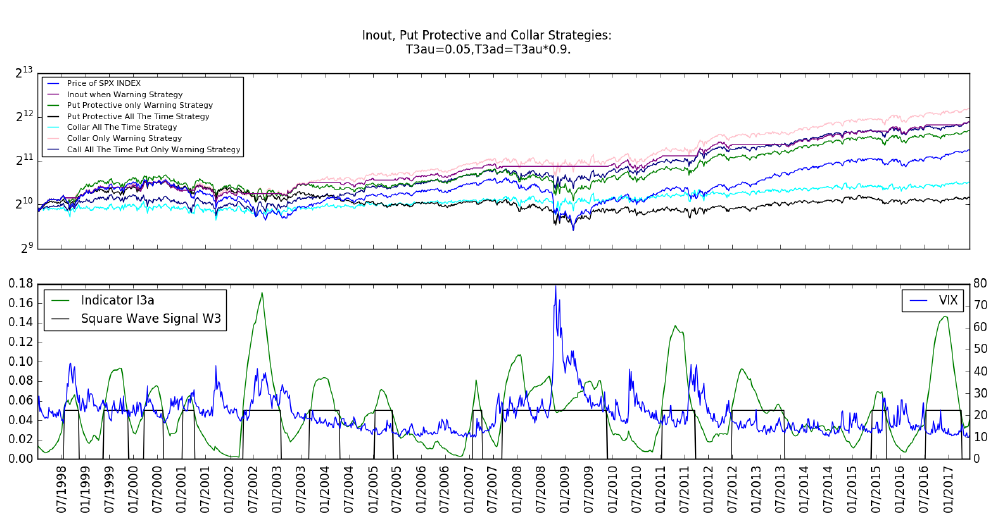
Figure 16. In-out, Put Protective and Collar Strategies based on W 3 .